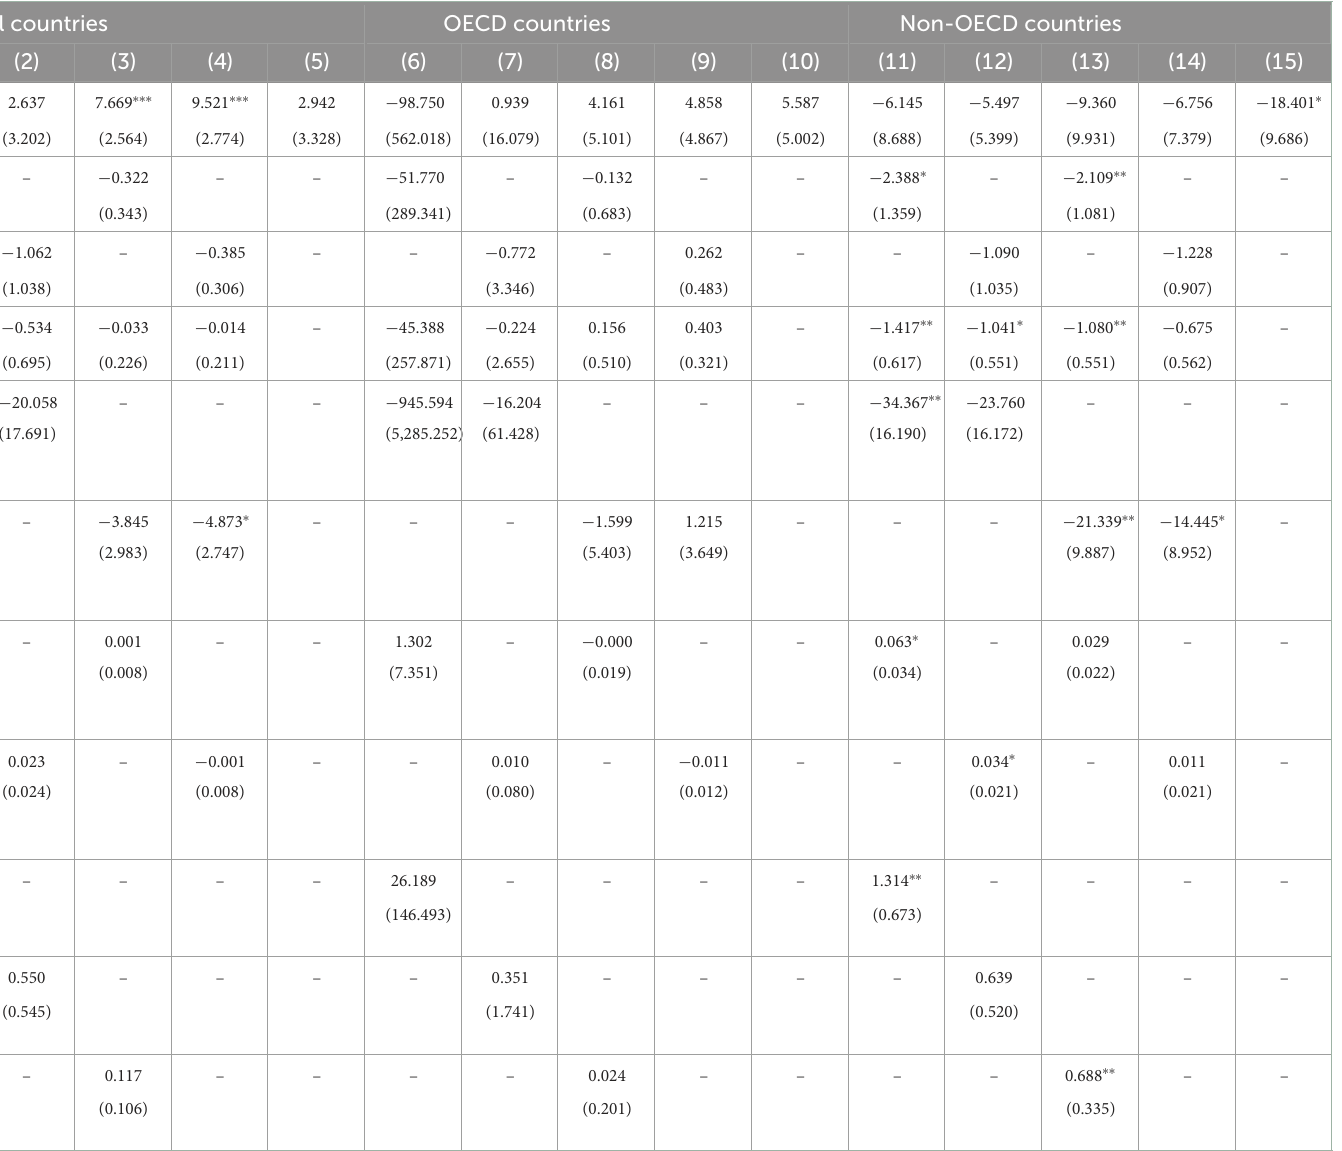
TABLE 5 Three-way interactive decentralization and